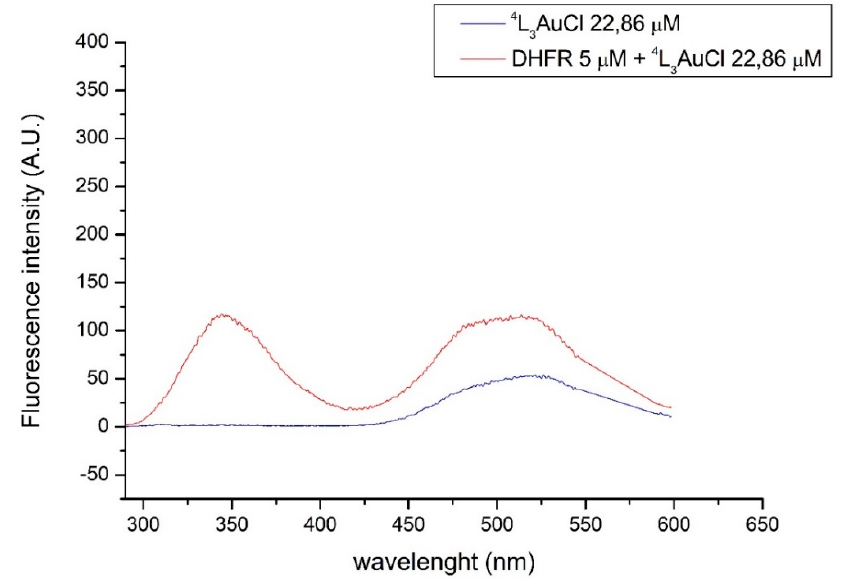
Figure 4. Comparison of the emission curves recorded for the intrinsic emission of 4 L 3 AuCl in Hepes/methanol solution in the absence and in the presence of DHFR ( 4 L 3 AuCl 22.86 μ M in both spectra, λ exc = 280 nm).